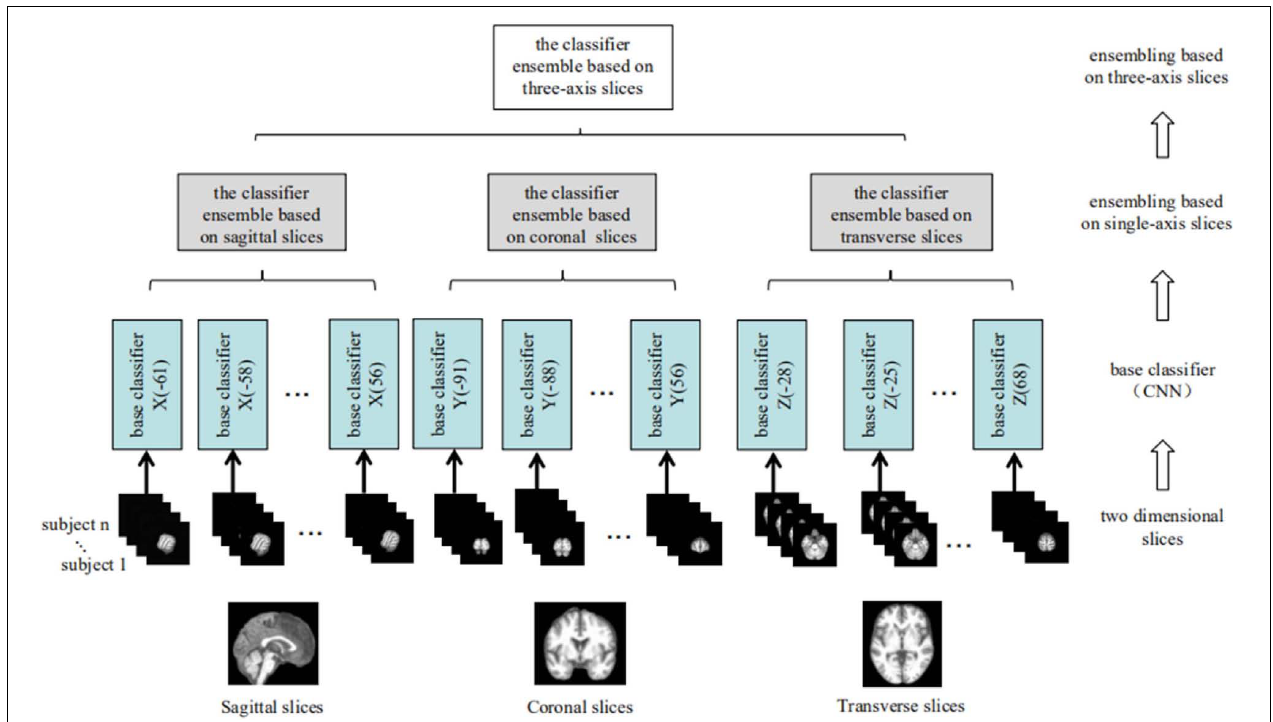
FIGURE 4 | The architecture of the classifier ensemble based on the three sets of 2D slices (from left to right: sagittal, coronal, and transverse).